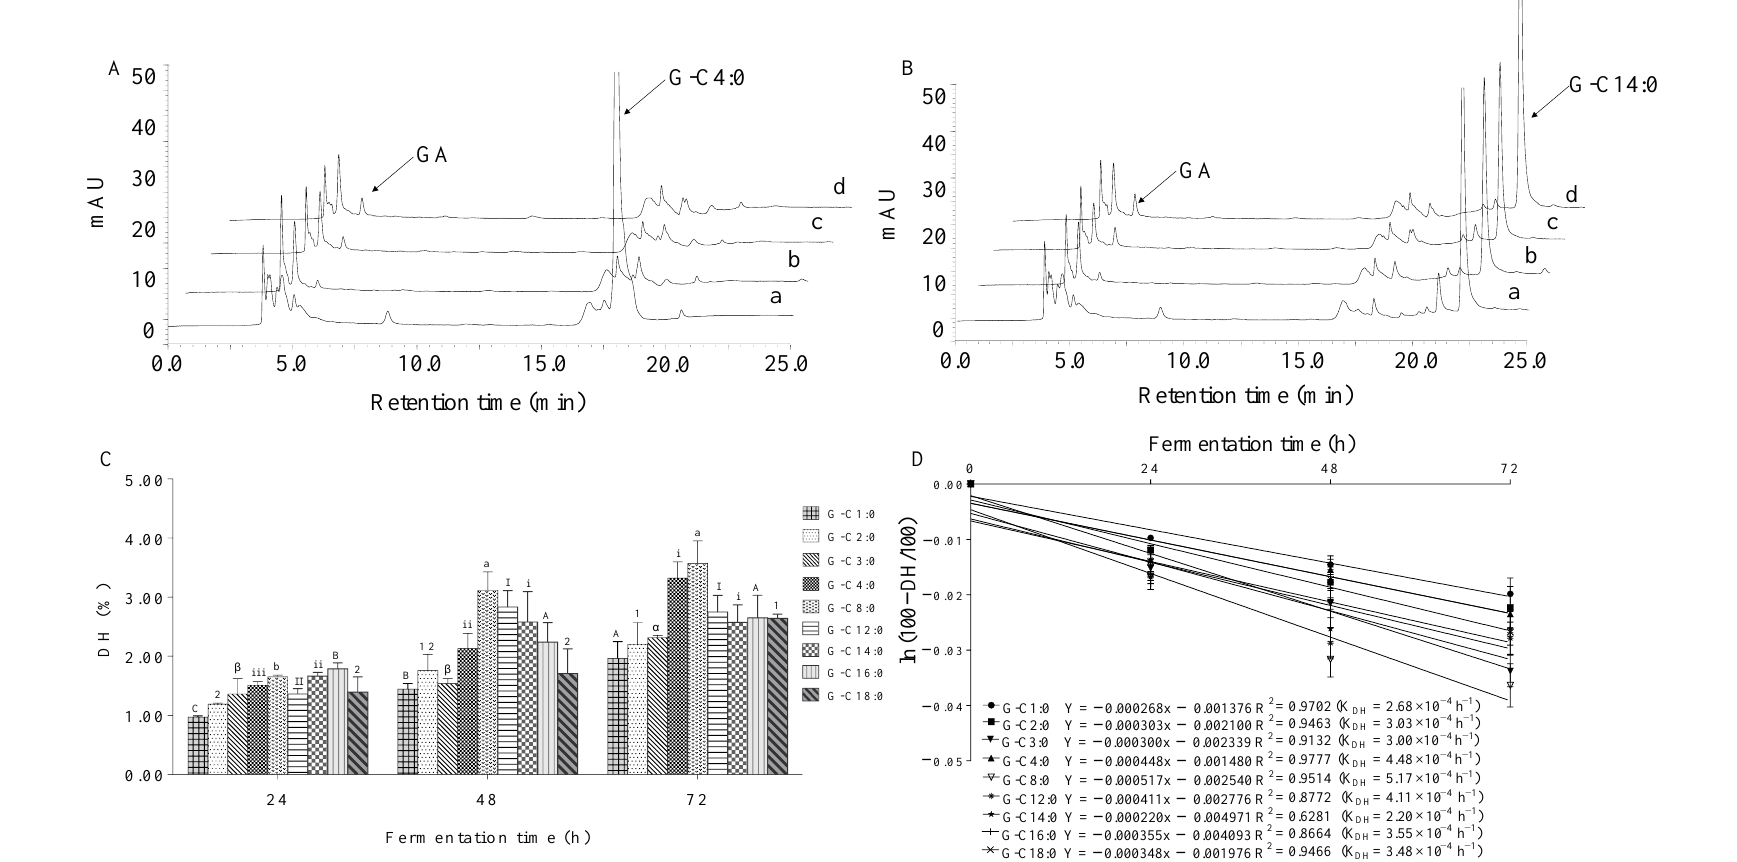
Figure 4. HPLC-UV chromatograms (G-C4:0 group-( A ) and G-C14:0 group-( B )), DHs ( C ) and kinetic models ( D ) of GA liberated from the hydrolysis of A-GAs by mice fecal microbiota: 0, 24, 48 and 72 h (a – d, respectively). Bars with different symbols (A – C, a – b, α–β, ⅰ – ⅲ , Ⅰ – Ⅱ , 1 – 2) are statistically differen t ( p < 0.05).